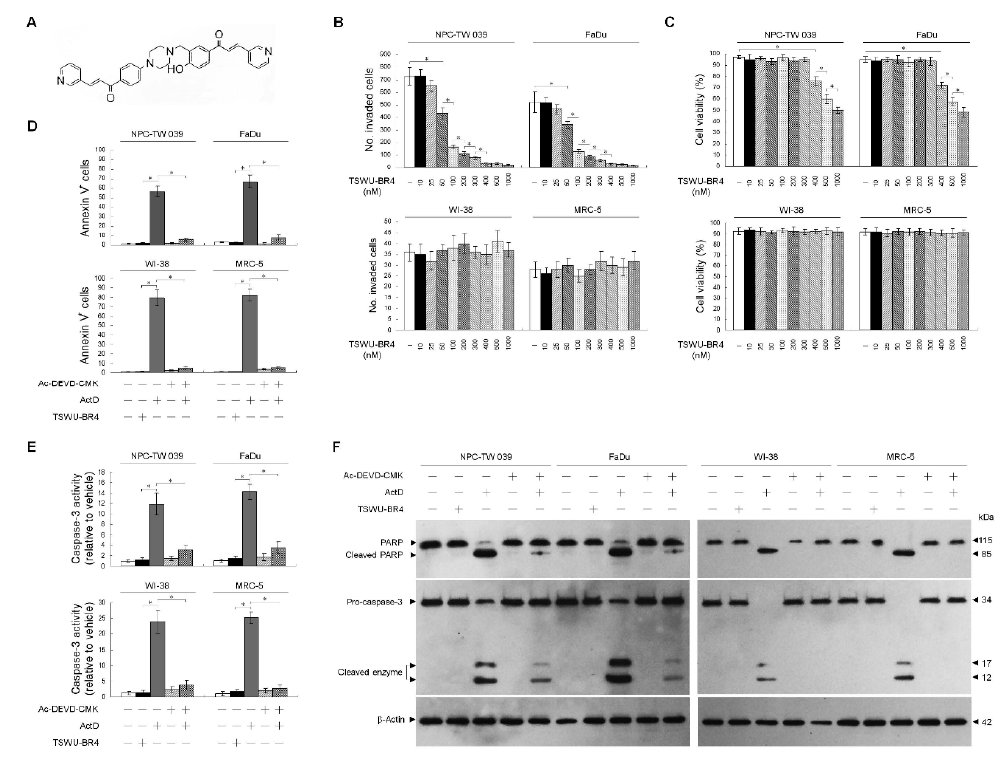
Figure 1. (( E ) ‐ 1 ‐ (4 ‐ Hydroxy ‐ 3 ‐ ((4 ‐ (4 ‐ (( E ) ‐ 3 ‐ (pyridin ‐ 3 ‐ yl)acryloyl)phenyl)piperazin ‐ 1 ‐ yl)methyl)phenyl) ‐ 3 ‐ (pyridin ‐ 3 ‐ yl)prop ‐ 2 ‐ en ‐ 1 ‐ one ( TSWU ‐ BR4) inhibits the invasive activity of cancer cells. ( A ) The structure of TSWU ‐ BR4. ( B,C ) The effect of TSWU ‐ BR4 on cancer cell invasion. Cells were treated with vehicle ( − ) or the indicated concentrations of TSWU ‐ BR4 for 36 h. The number of invaded cells was assessed using the Matrigel invasion assay. Cell viability was determined by the flow cytometric analysis of PI uptake. The values are presented as the means ± standard error (S.E.M.) of three independent experiments. * p < 0.05: significantly different from vehicle ( − ) or TSWU-BR4-treated cells. ( D – F ) The effect of TSWU ‐ BR4 on the induction of cancer cell apoptosis. After a 36 h treatment with vehicle, TSWU ‐ BR4 (300 nM), ActD (10 μ M), or ActD and Ac ‐ DEVD ‐ CMK (8 μ M), the percentage of Annexin V+ cells and caspase ‐ 3 activity were determined using flow cytometry. The values are presented as the S.E.M. of three independent experiments. * p < 0.05: significantly different from TSWU ‐ BR4 − or ActD ‐ treated cells. The levels of PARP and caspase ‐ 3 in the cell lysates were determined by Western blot analysis with specific antibodies. β‐ Actin was used as an internal control for sample loading.